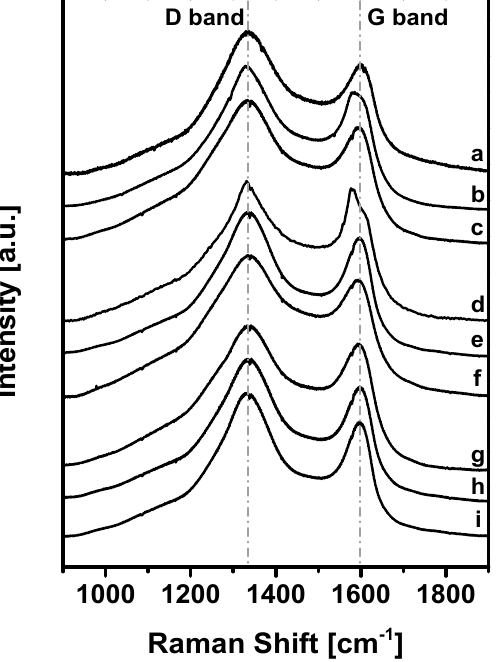
Figure 6. Raman spectra in the region 1900–900 cm − 1 of KUPO carbon samples. The curves correspond to the samples reported in Table 2. Table 2. I D /I G values obtained from Raman spectra for all the KUPO carbons. Curve Sample I D / I G